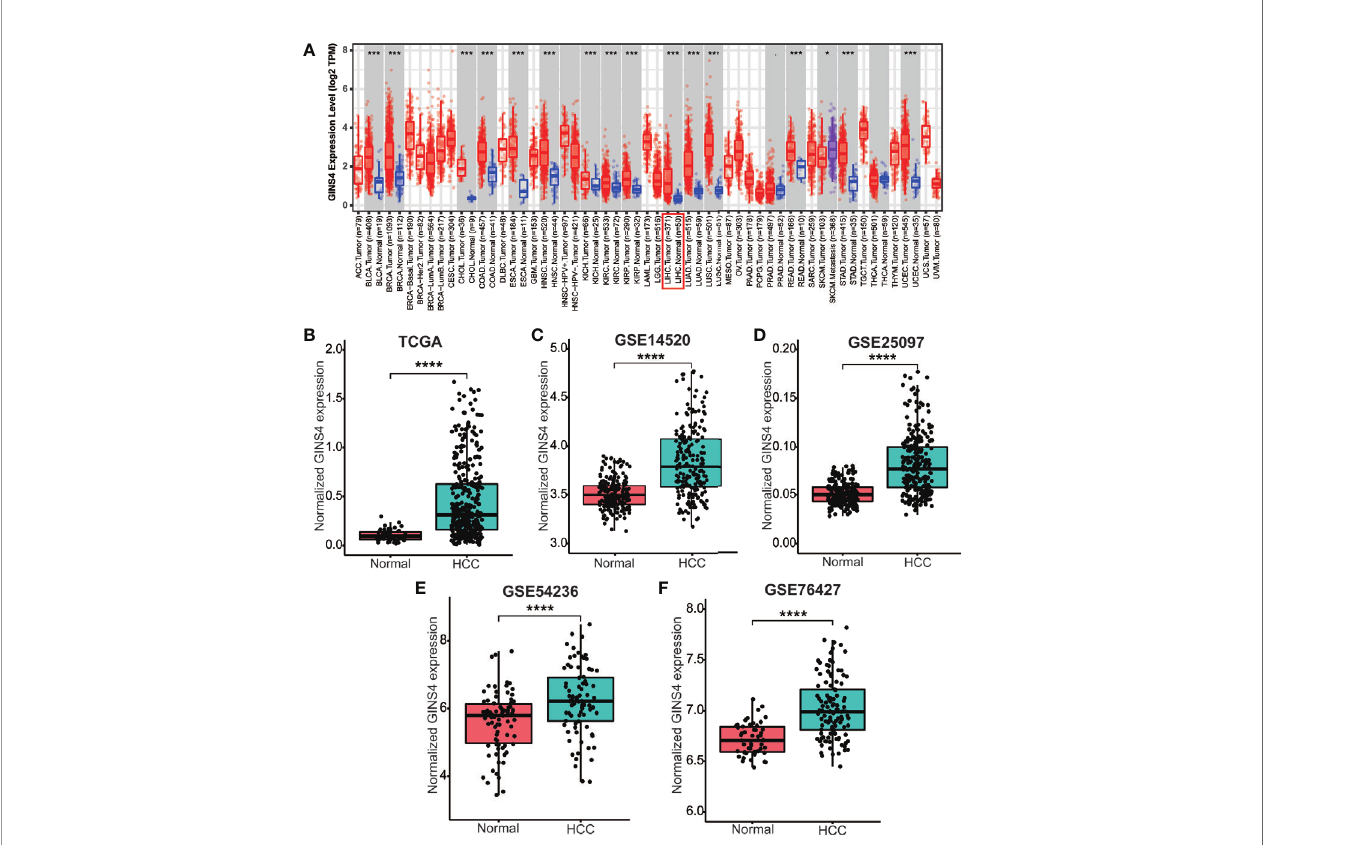
FIGURE 3 | GINS4 mRNA levels are signi fi cantly upregulated in HCC. GINS4 mRNA expression in HCC and adjacent normal samples extracted from (A) the TIMER, (B) the TCGA, (C) GSE14520, (D) GSE25097, (E) GSE54236, and (F) GSE76427 database. (*P < 0.05, ***P < 0.001, and ****P <